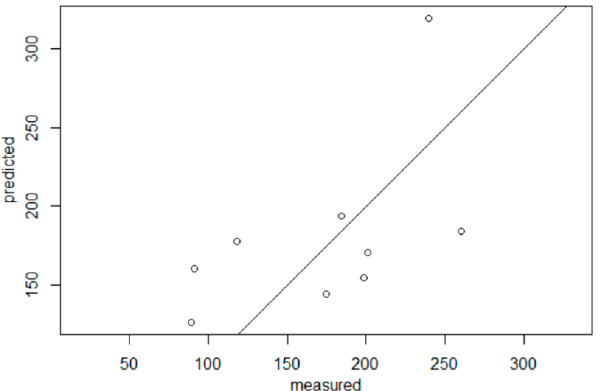
estimate; adjCV : the bias-corrected CV estimate [44].